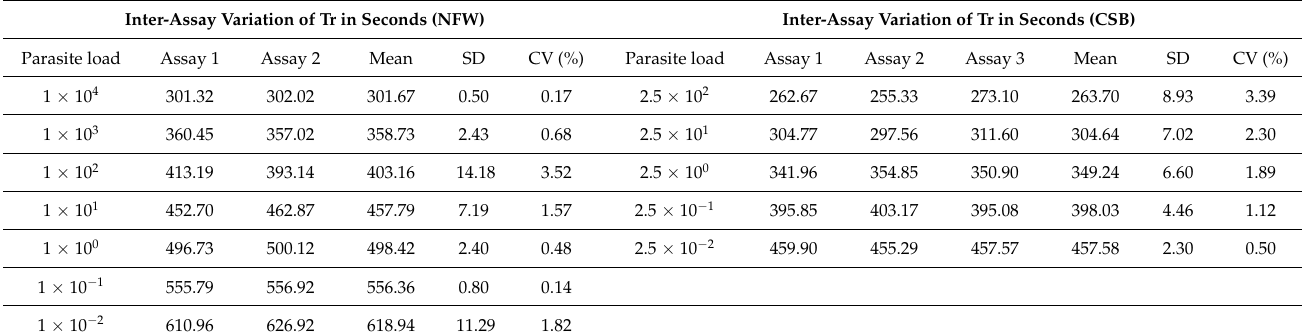
Figure 2. Performance of Q-RPA for obtaining standard curve. Tr values are plotted from replicated assay runs against parasite load equivalent genomic DNA. The plot represents Tr values and parasite load fitting a linear function. ( a ) DNA extracted from reference strain and diluted in NFW in the range of 10 4 to 10 − 2 parasite per reaction and assayed in duplicate ( b ) DNA extracted from parasite spiked blood to give a range of 2.5 × 10 2 to 2.5 × 10 − 2 parasite per reaction and assayed in triplicate. Table 1. Reproducibility of the Q-RPA assay.